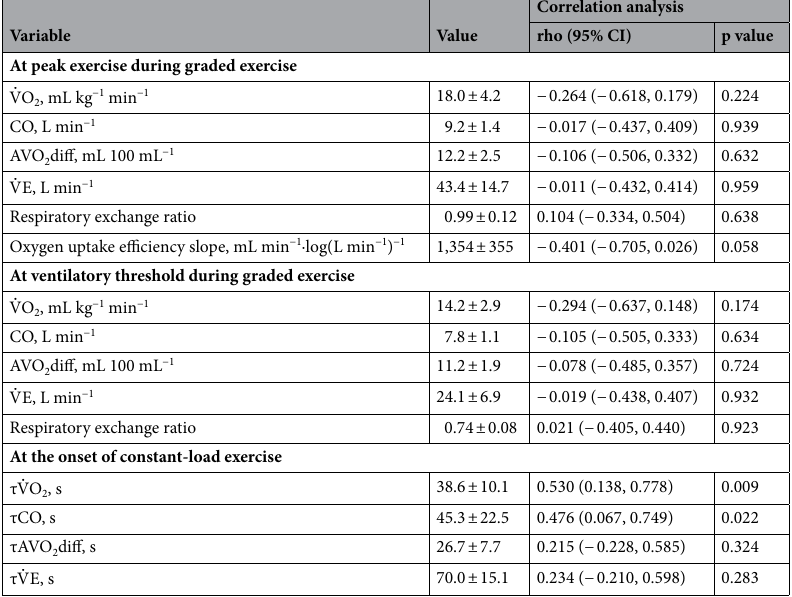
˙ V O 2 oxygen uptake, CO cardiac ˙ V E minute ventilation, τ the time